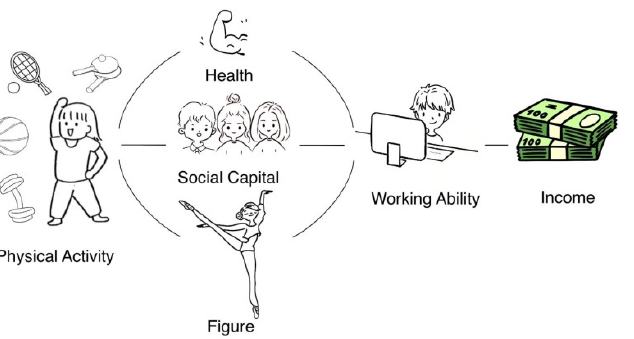
Figure 1. The mechanism of participating in physical exercise to improve personal income level.